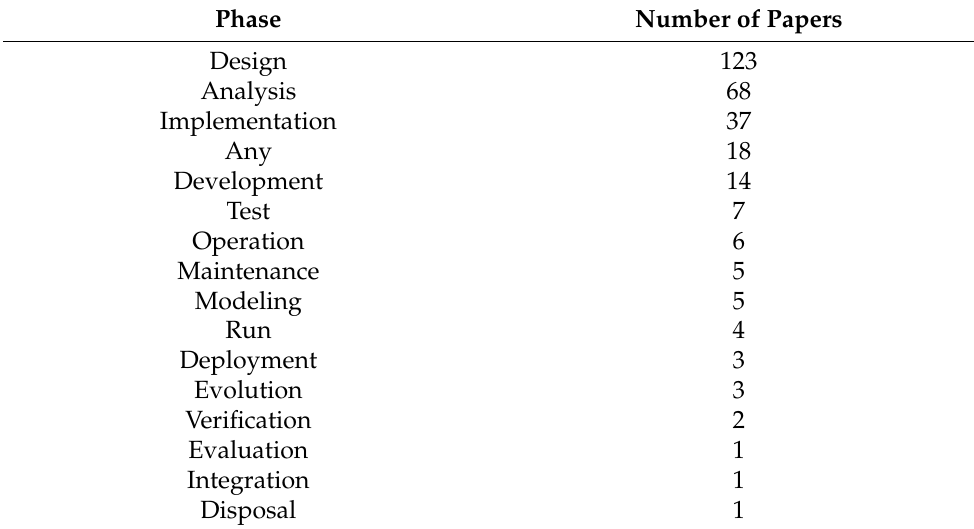
Table 1. Phases targeted by security pattern research.